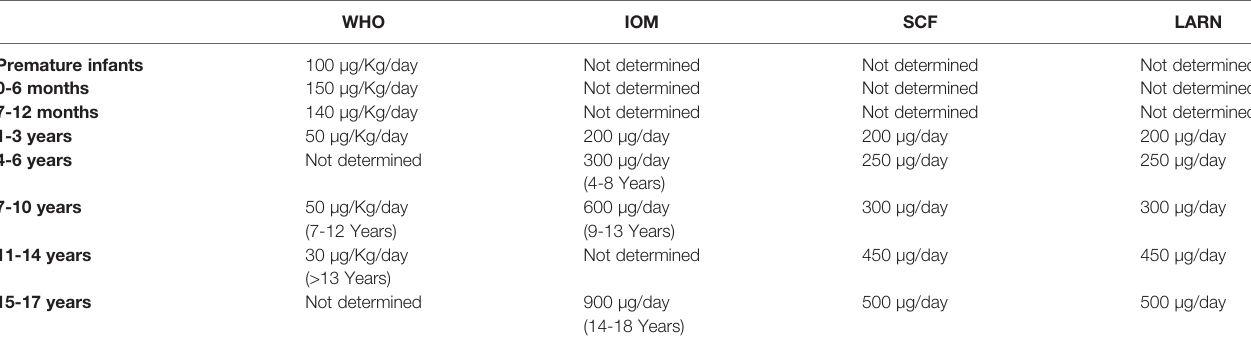
TABLE 3 | Recommended upper intake levels for iodine according to different institution (3,